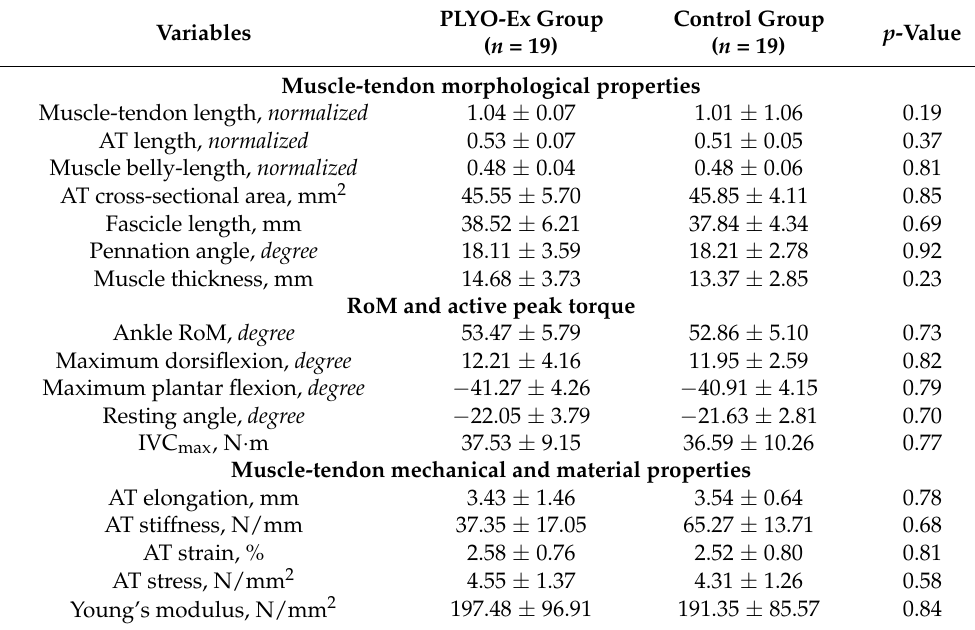
Table 2. Dependent outcome measurements at baseline in the PLYO-Ex and control groups. PLYO-Ex Group Control Group p -Value Variables ( n = 19) ( n = 19) Muscle-tendon morphological properties Muscle-tendon length,